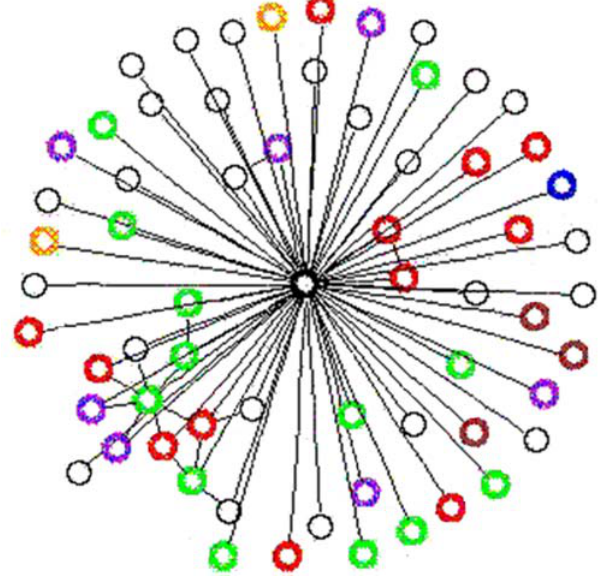
Figure 4. Prediction of ‘‘larval development’’ annotation for the gene CG10701. The sub-network of the D. melanogaster PPI- network containing the genes CG10701, in the middle, and its direct neighbors. Neighbors that currently lack process annotations are black. Neighbors that are annotated with the GO-process ‘‘larval develop- ment’’ are blue. Neighbors that are annotated only with processes which were not found to have a PPI-link to ‘‘larval development’’ are red. The other neighbors are annotated with at least one process that was found to have a PPI-link to the predicted process. Purple: cell organization and biogenesis; Green: cell communication; Brown: locomotory behavior; Orange: morphogenesis of an epithelium.